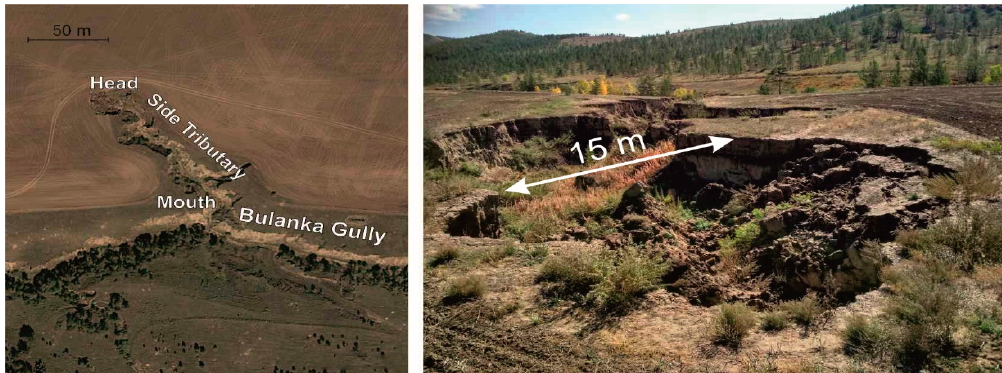
Figure 3. Object of monitoring—Bulanka gully tributary.